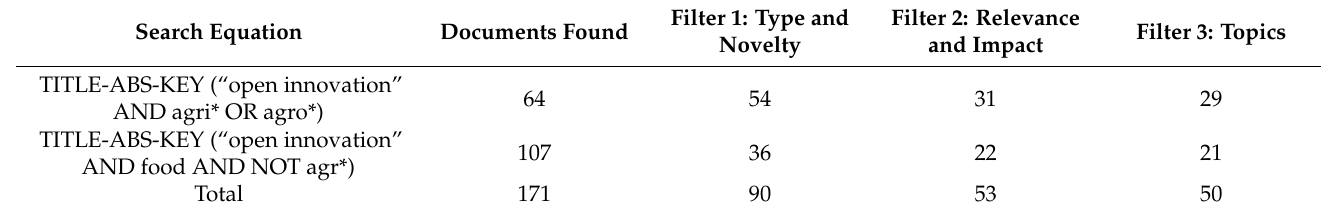
Table 1. Document selection